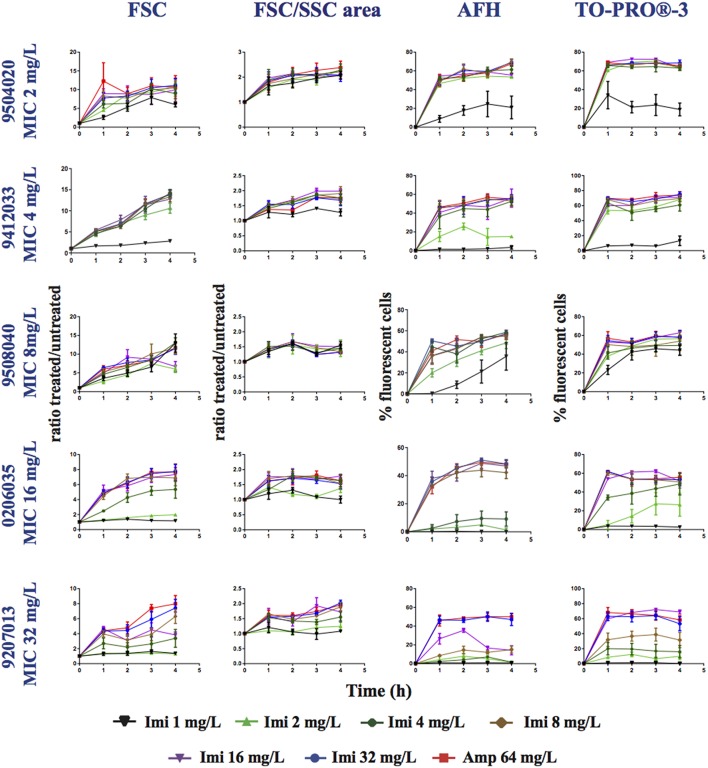
Monitoring alterations of the P. aeruginosa strains treated with a range of imipenem concentrations via flow cytometry. P. aeruginosa strains having different MICs (see Table 1) for imipenem were treated with a range of concentrations of imipenem (1, 2, 4, 8, 16, 32, or 64 mg/L). This figure shows the ratios of the mean FSC intensity of the imipenem-treated samples/the mean FSC intensity of the untreated samples, the ratios of the FSC/SSC area of the imipenem-treated samples/the FSC/SSC area of the untreated samples, and the percentage of fluorescent cells stained with AFH and TO-PRO®-3, all relative to incubation time. Each value represents the mean value obtained from four independent experiments. The error bars correspond to the standard error of the mean.